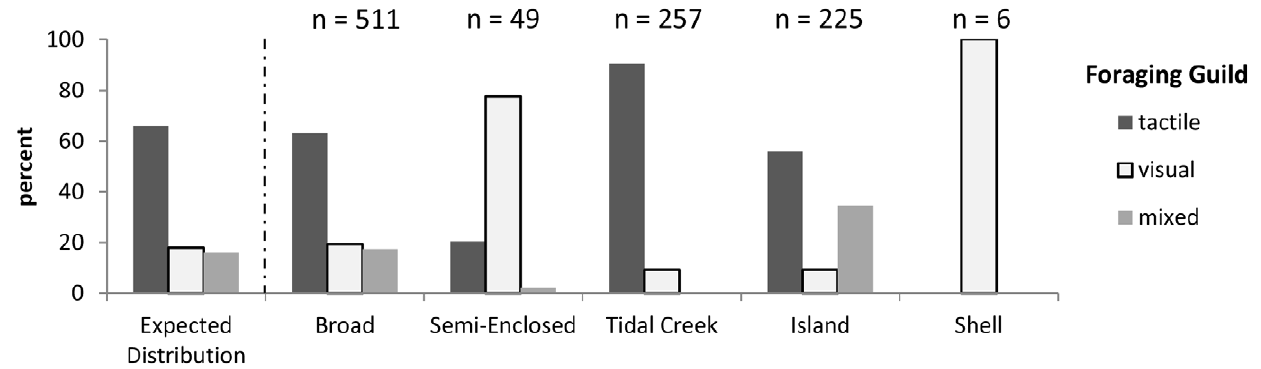
Figure 5. Flat use by shorebird foraging guild. Percentages are flat-specific. All tidal stages combined.